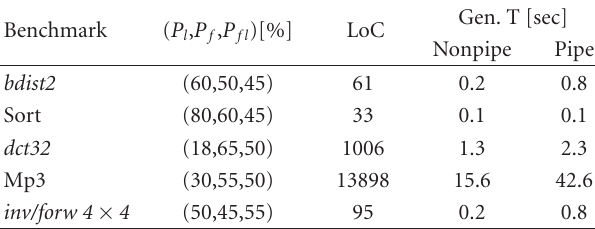
Table 4: Parameter values and code size